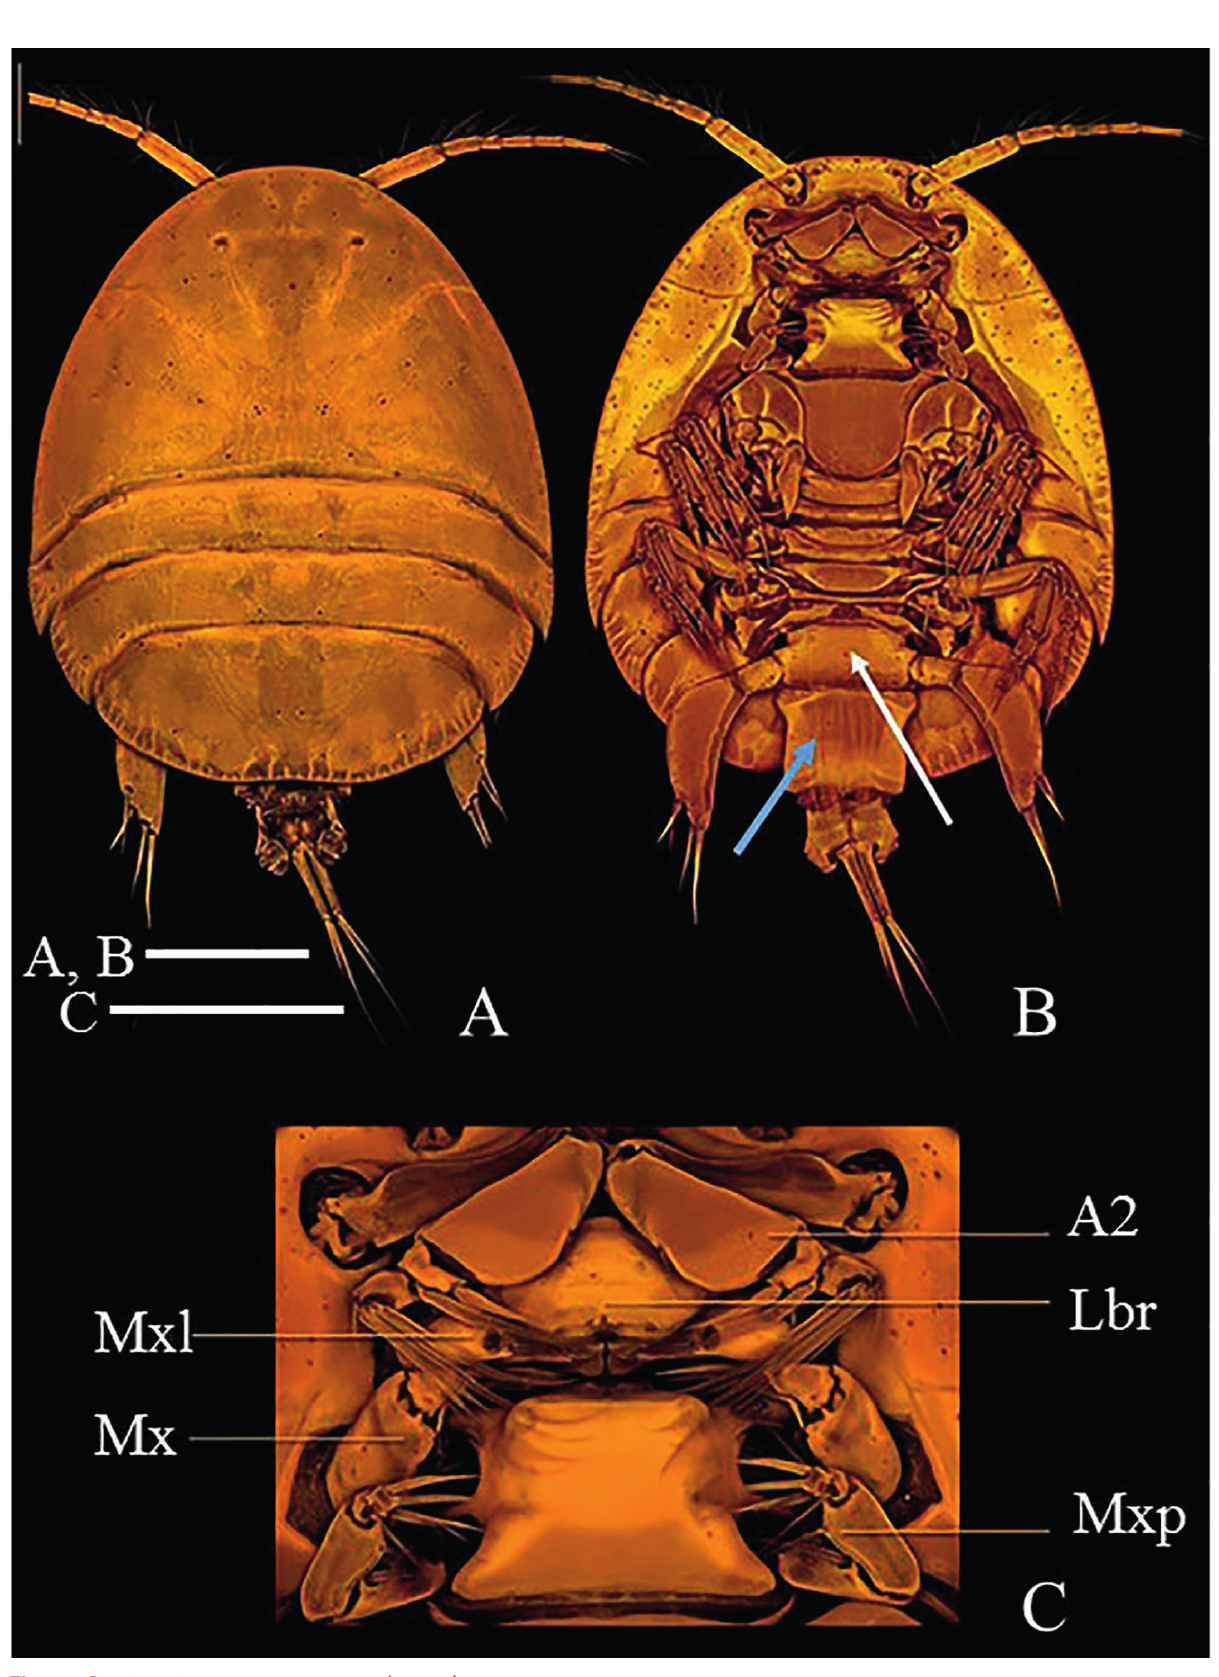
Figure 8. Clausidium persiaensis sp. nov. (female). Confocal laser scanning microscopy images. A, habitus, dorsal; B, habitus, ventral; C, oral region. White arrow = somite that bears P5; blue arrow = genital double somite. Scale bars: A, B, 200 μm; C, 100